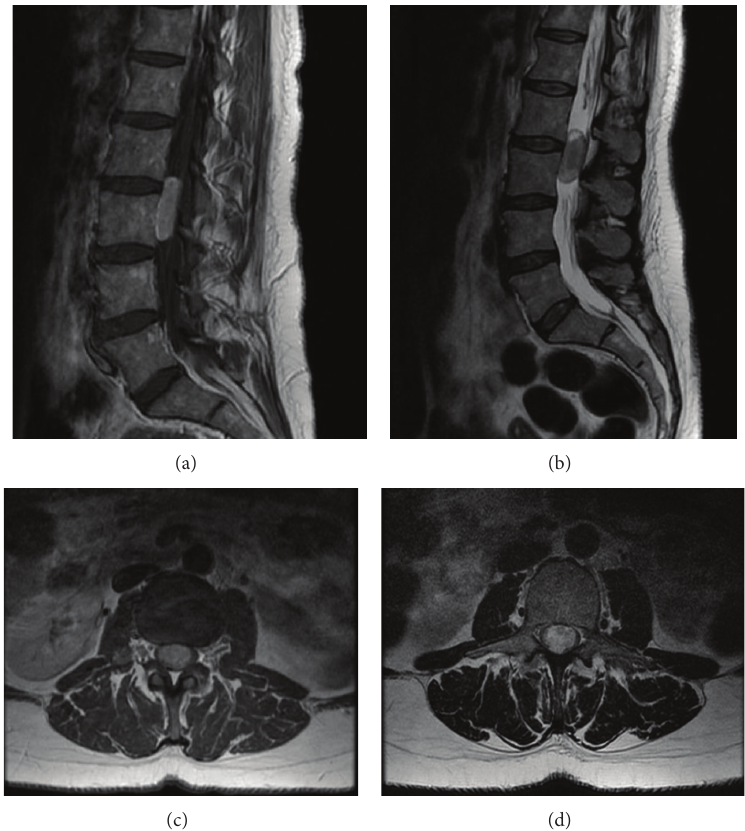
Figure 4: (a) Pre-op sagittal T1 with contrast MRI showing L2-L3 paraganglioma. (b) Pre-op sagittal T2 MRI showing L2-L3 paraganglioma. (c) Pre-op axial T1 with contrast MRI showing L2-L3 paraganglioma. (d) Pre-op axial T2 MRI showing L2-L3